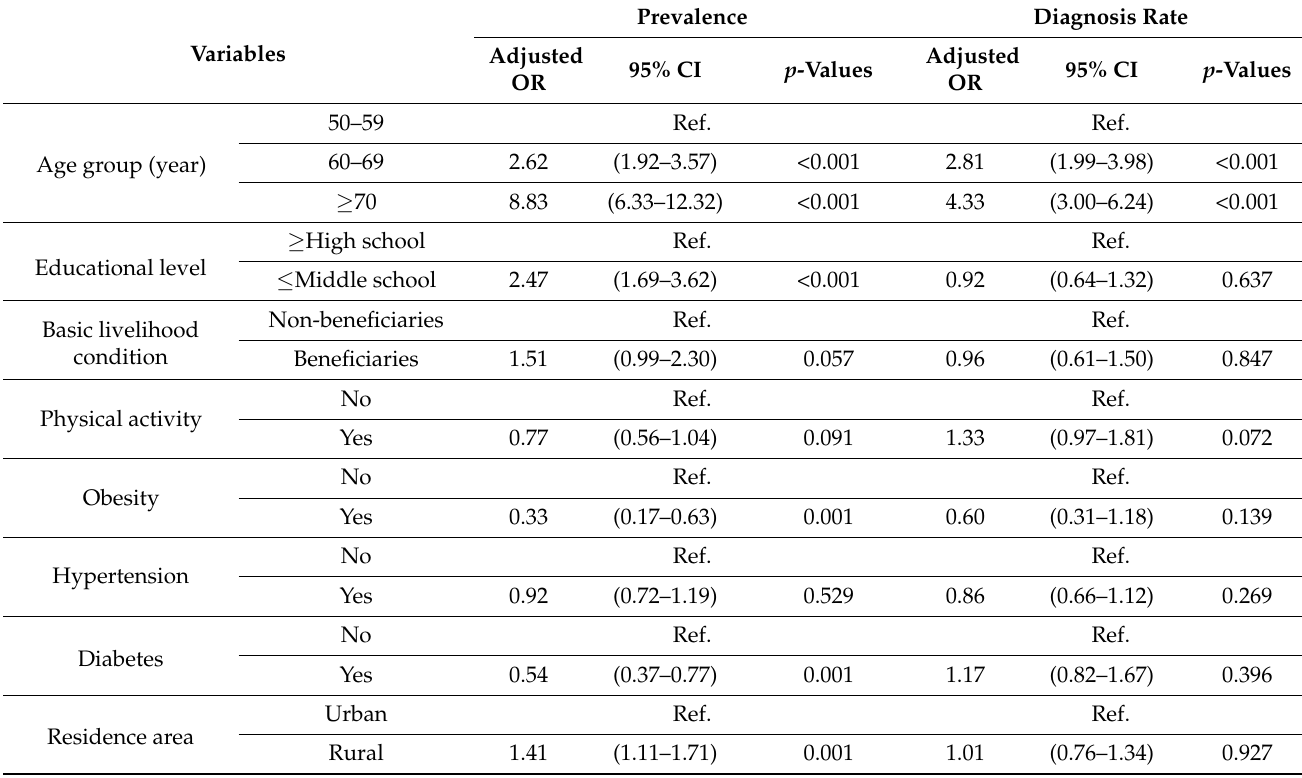
Table 3. Multivariate logistic regression analysis of the influence of the factors on the osteoporosis prevalence and diagnosis rate in the total